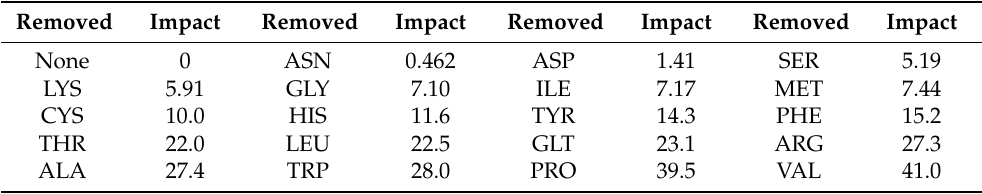
Table 2. Impact (ascending left to right) of inhibiting amino acid uptake on the model relative to MHHW. Impact is the Euclidean distance between the reference (MHHW) solution flux vector, and that obtained by inhibiting amino acid uptake Removed Impact